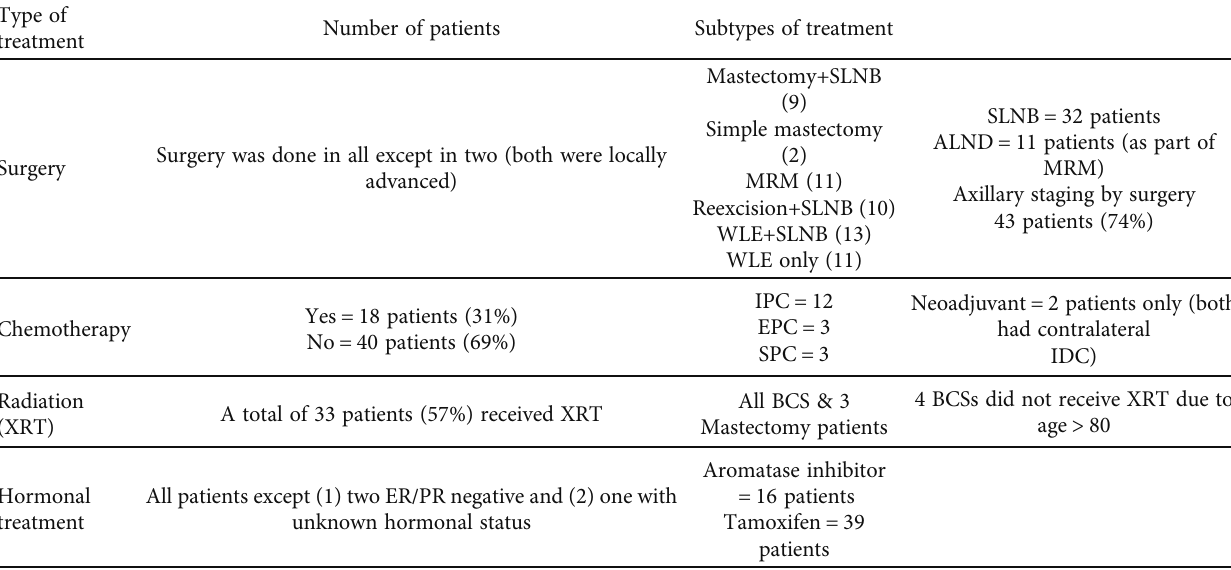
Table 4: Di ff erent treatment